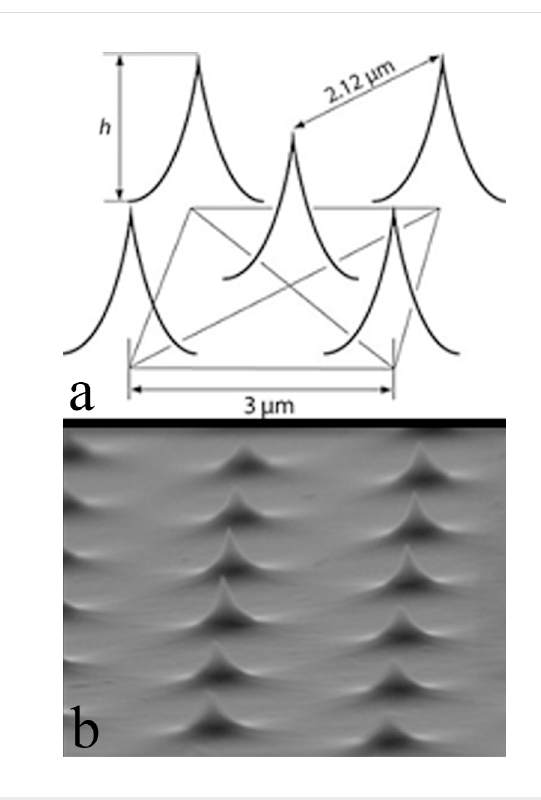
Figure 1: Test grating. a) Lattice features given by the manufacturer. b) Scanning electron microscopy image of the array of sharp silicon peaks of the actual test grating (TGT1) used in our experiments ob- tained with a JSM7800-LV microscope.